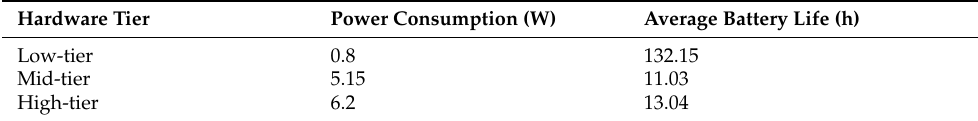
Table 8. Hardware performance of each